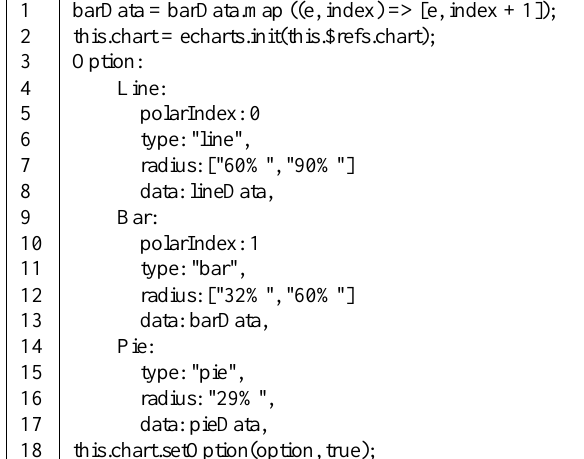
Table 1. Key pseudocode for glyph